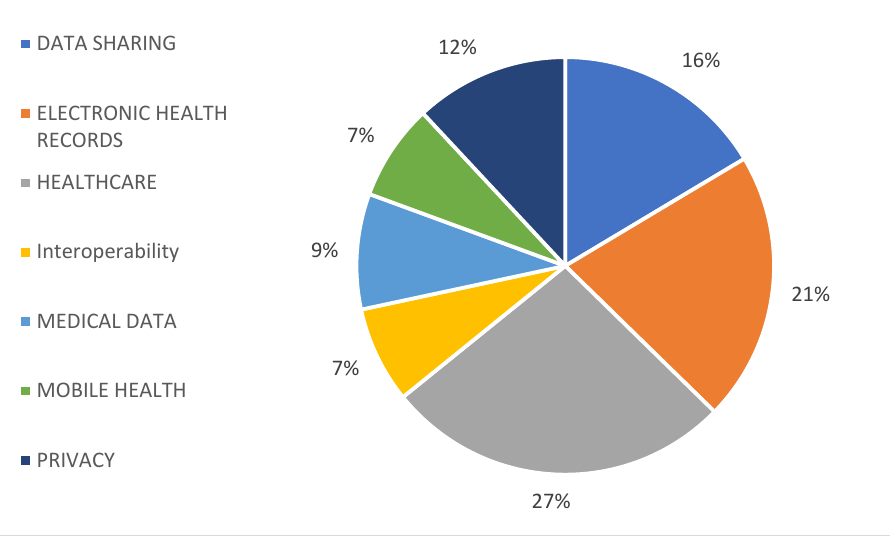
Figure 1. PRISMA process used in the literature review process.